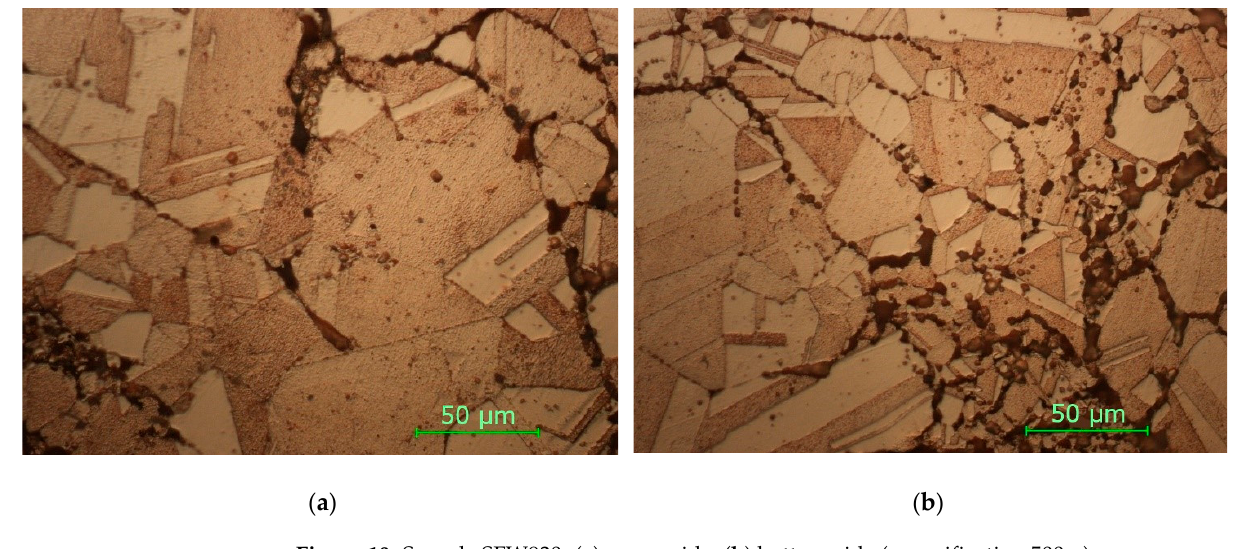
Figure 10. Sample SFW930: ( a ) upper side; ( b ) bottom side (magnification 500×).